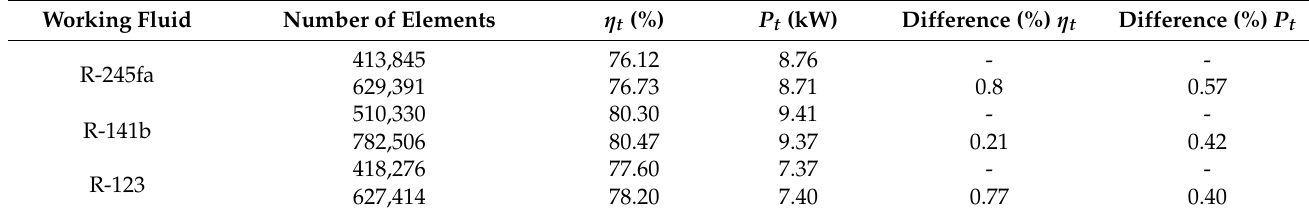
Table 5. Results of the mesh independent